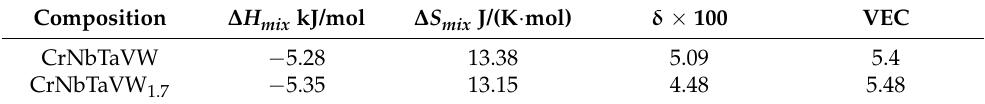
Table 2. Thermodynamic calculations for the CrNbTaVW and CrNbTaVW 1.7 high entropy alloys. Composition ∆ H mix kJ/mol ∆ S mix J/(K · mol) δ × 100 VEC